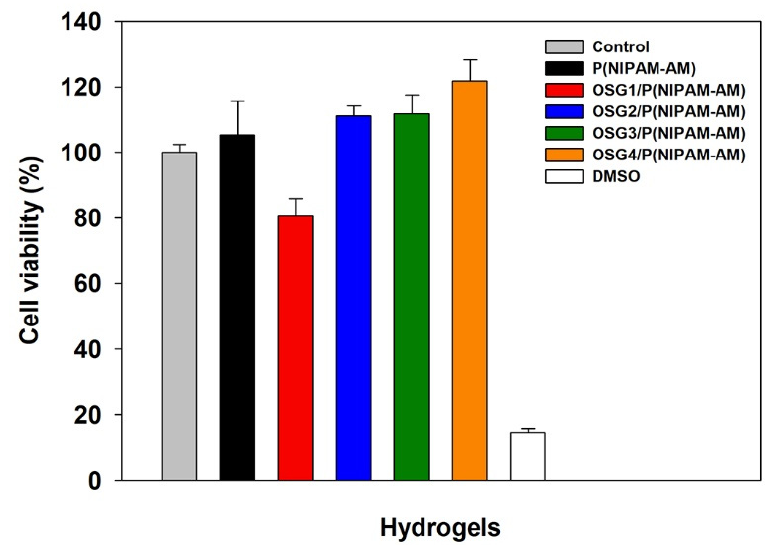
Figure 10. Cytotoxicity of the hydrogels. Cell viability of HEK-293 cells cultured with hydrogels for 48 h. DMSO was used as a positive control.